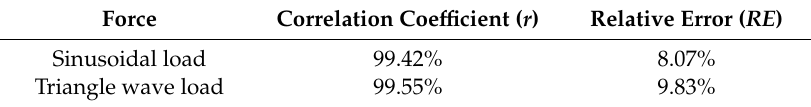
Figure 33. Identification result of triangle wave load. Table 8. Evaluation of identification results of